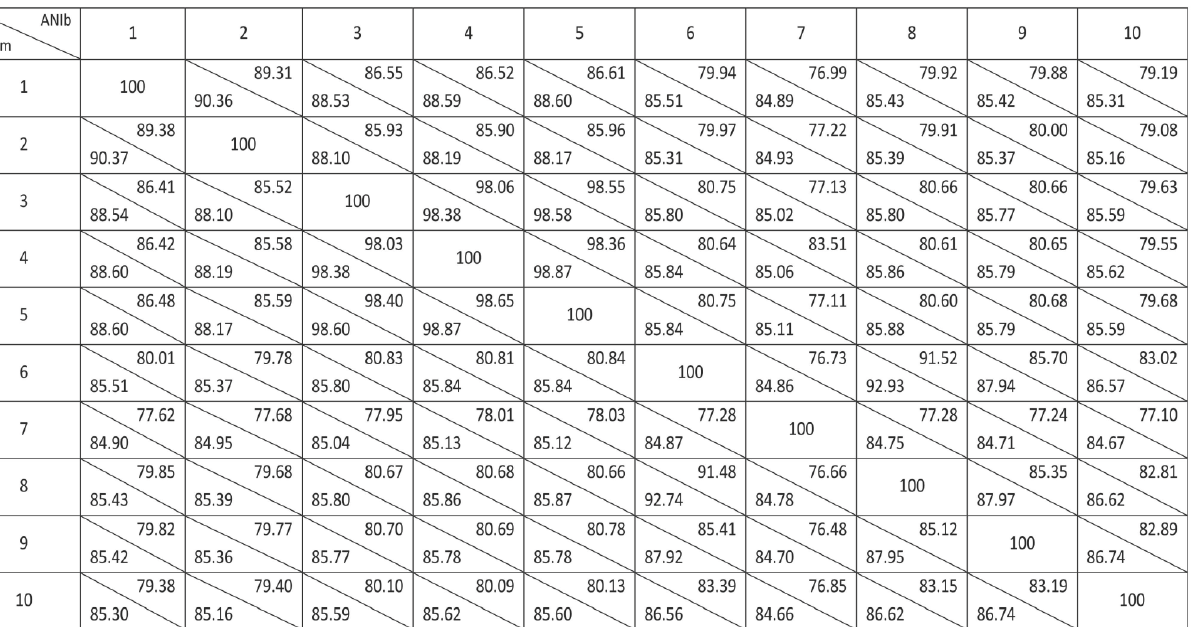
Table 1. Prediction of secondary metabolites in Pseudomonas sp., strain L5B5. Similarity of core bi ‐ osynthetic genes and presence of metabolites in closer relatives are shown.